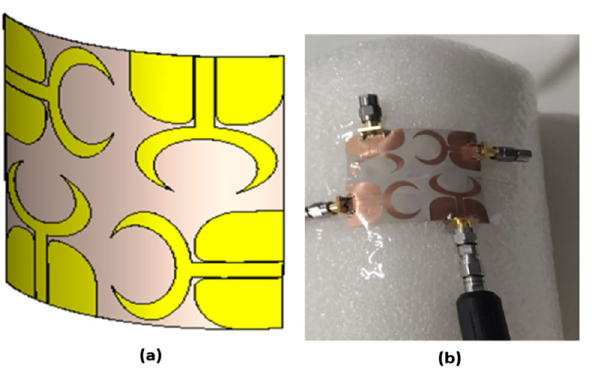
Figure 14. Flexible MIMO antenna configuration with radius R of 45 mm ( a ) 2 D view, ( b ) fabricated photo